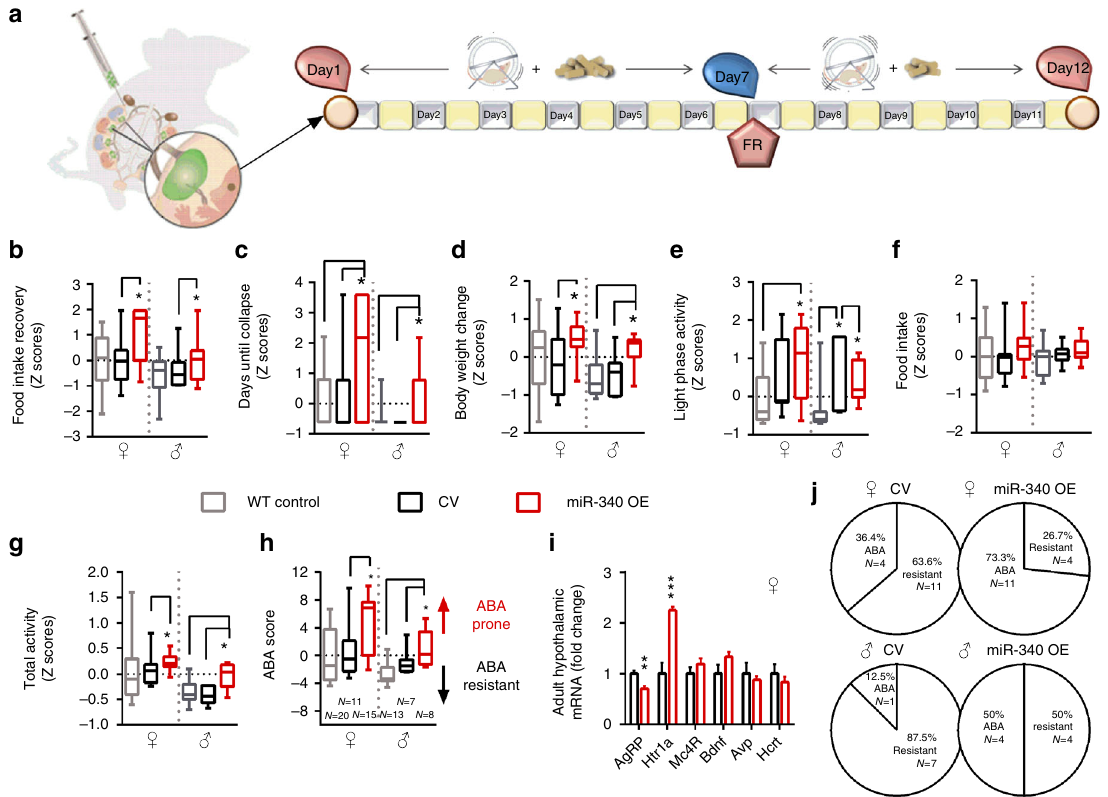
Fig. 6 Placental miR-340 overexpression (OE) robustly increases the susceptibility to activity-based anorexia (ABA) in both sexes. a Transgene animals of both sexes were exposed to the ABA protocol. b − g MiR-340 OE transgenes of both sexes scored higher than controls in food intake recovery (one-way ANOVA F (5,68) = 4.49, p = 0.0014) ( b ), days until collapse ( F (5,68) = 5.36, p = 0.0003) ( c ), body weight (BW) change ( F (5,68) = 3.99, p = 0.003) ( d ), circadian disruption (light phase activity) ( F (5,68) = 5.01, p = 0.0006) ( e ) and total activity ( F (5,68) = 6.81, p < 0.0001) ( g ) during the food restriction part of the protocol. In contrast, food intake during food restriction did not signi fi cantly differ between the groups ( f ). h Altogether, placental miR-340 OE robustly increased the susceptibility to ABA in both sexes compared to both WT controls and CV animals ( F (5,68) = 6.83, p < 0.0001). Data presented as min to max with median. Differences between the groups are based on Tukey ’ s multiple comparisons test. * p < 0.05. i Hypothalamic gene expression of anorexia candidate genes differed between CV and miR-340 OE females (MANOVA F (6,5) = 53.83, p < 0.000), with low expression of AgRP and high expression of Htr1a . Data are presented in mean and s.e.m. ( N = 6). j MiR-340 OE increased the susceptibility to ABA in both sexes. CV control